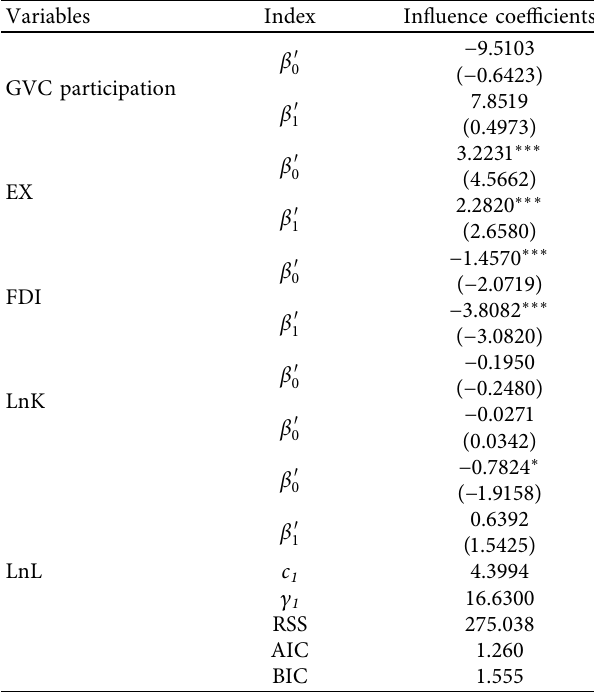
Table 6: Regression results of the low energy consumption trade. Table 5: Regression results of the high energy consumption trade.